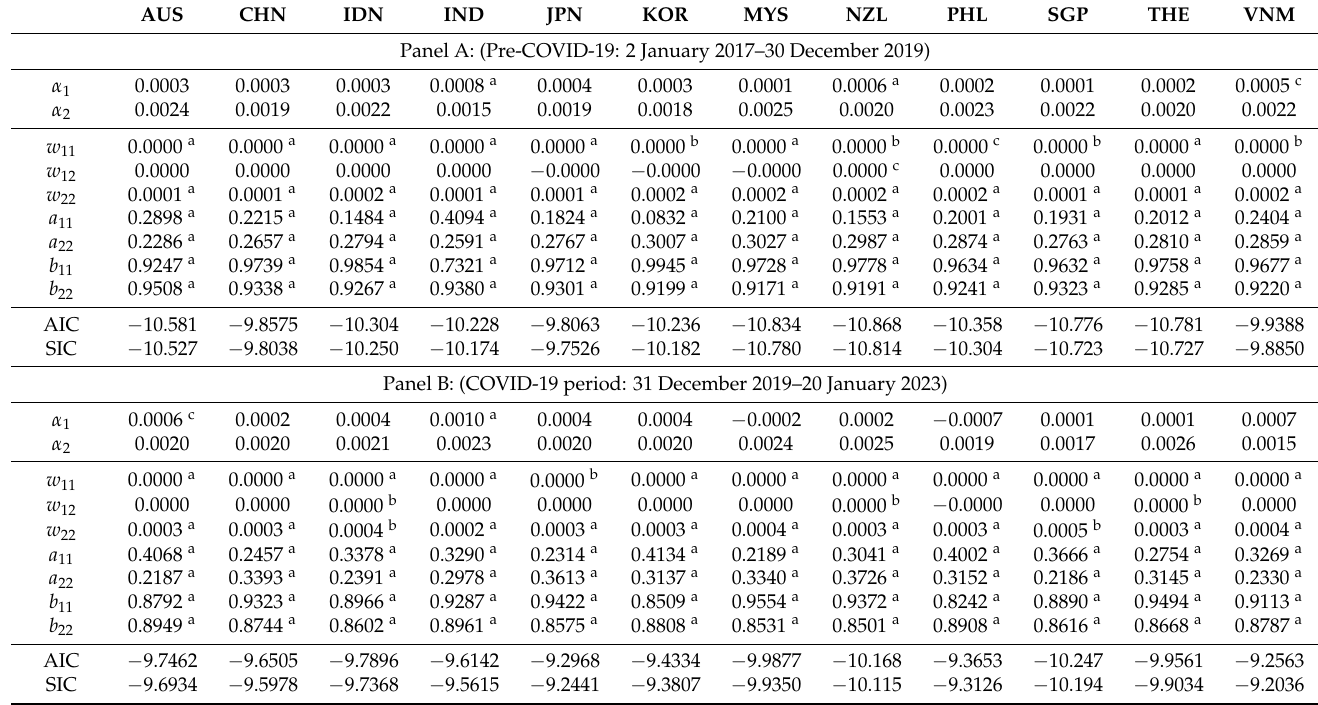
Table 4. BEKK–GARCH estimated results between Bitcoin and ASEAN+6 stock